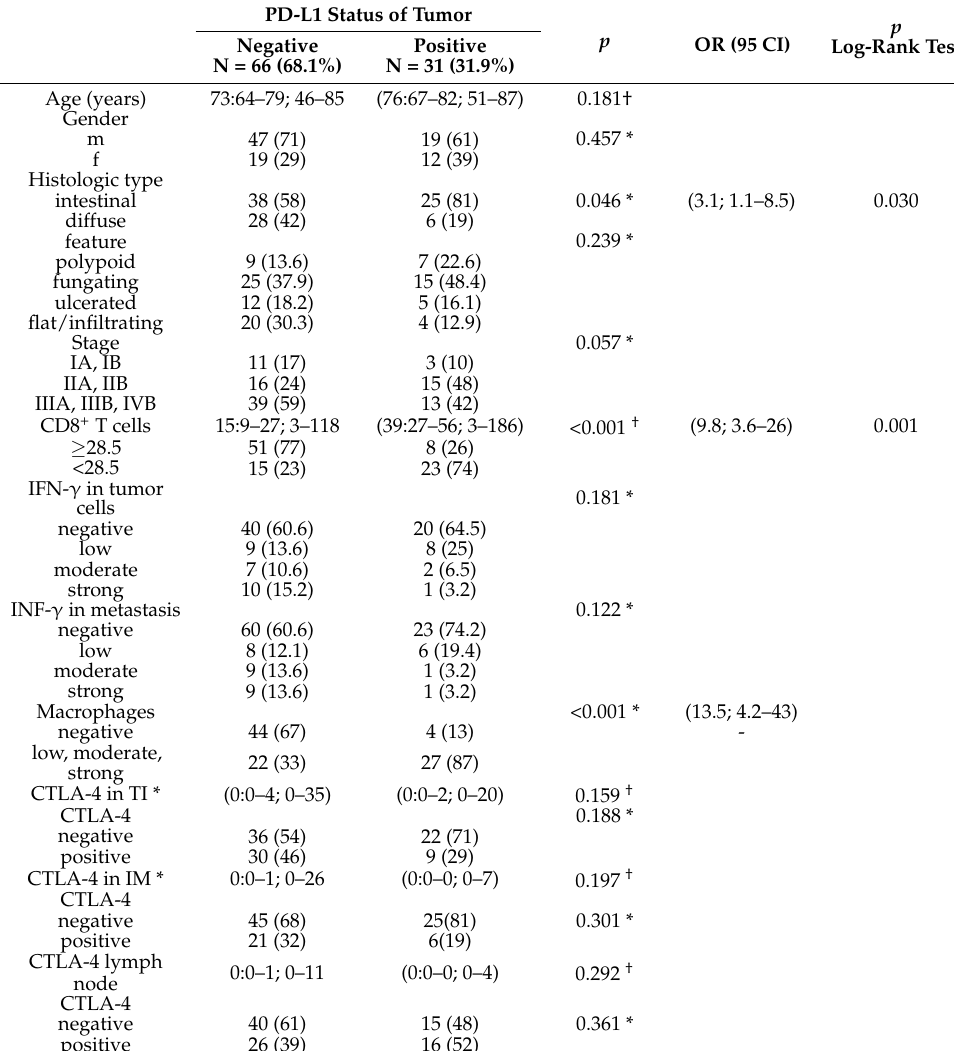
Table 2. Correlation of PD-L1 status of GC with clinical and pathological